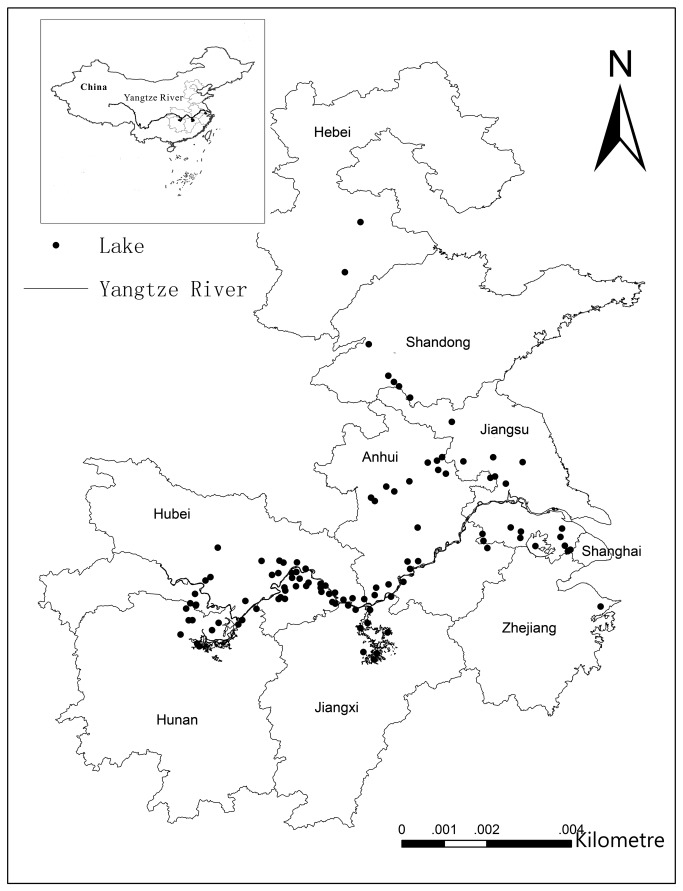
Distribution of the study lakes in the eastern plains area of China.